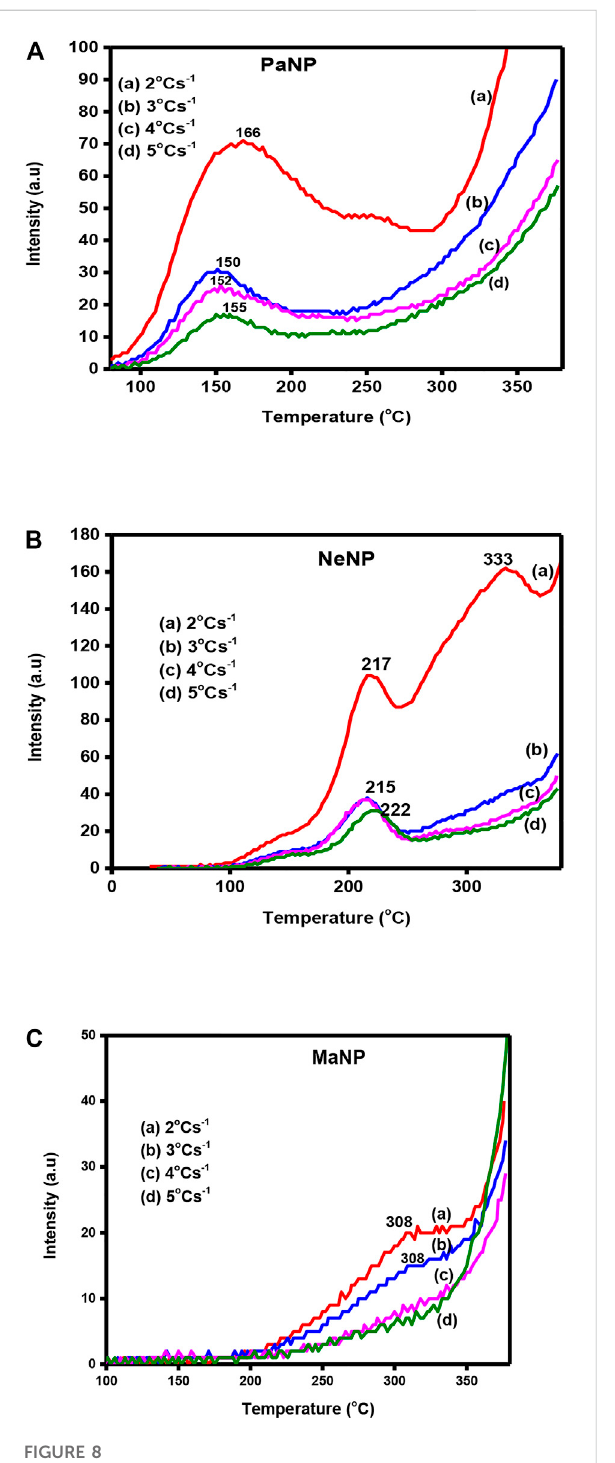
FIGURE 9 Thermally cleaned TL glow curves of (A) PaNP, (B) NeNp, and (C)